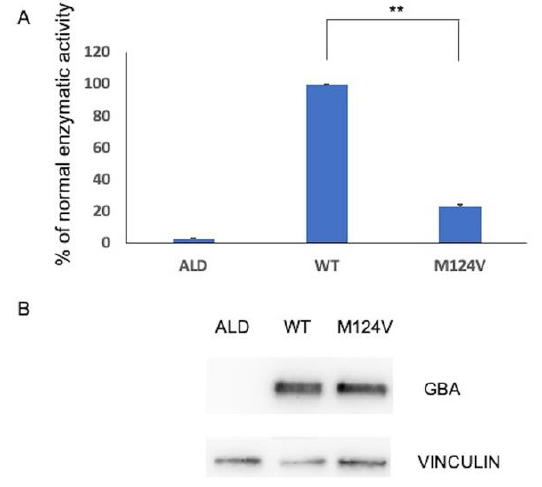
Figure 3. Functional analysis of the novel p.M124V (M85V) missense mutation. ( A ) GCase activity in Hek293- GBA KO cells transiently transfected with the pCDNA3- GBA WT (WT) plasmid and pCDNA3 GBA M124V (M124V). Values are expressed as the percentage of wild-type activity and represent the mean ± SEM of three independent experiments. ** p < 0.001. pCDNA3 ALD was used as a negative control. ( B ) Western blot analysis of WT and mutant GBA protein expressed in Hek293- GBA KO cells.